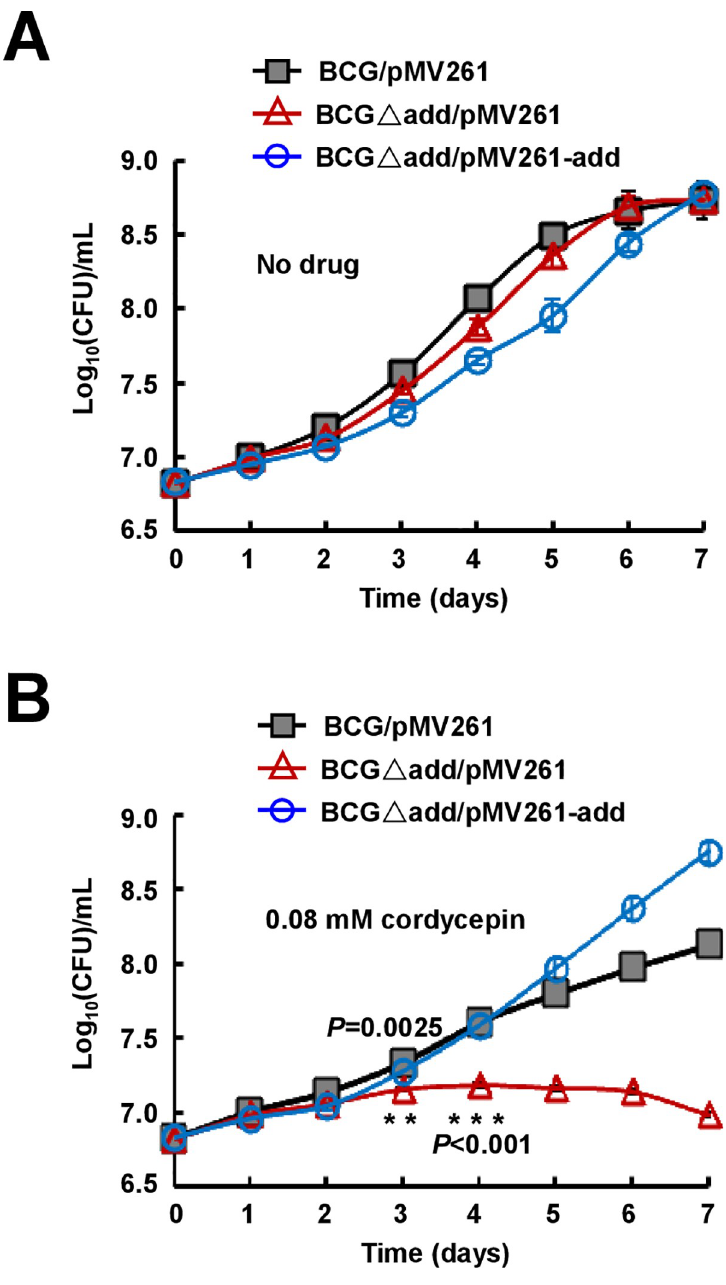
Fig 5. Effects of adenosine deaminase shunt on the mycobactericidal activity of cordycepin. Mycobacterial strains were grown in 7H9 medium without (A) or with 0.08 mM cordycepin (B). The add -deleted BCG strain is more sensitive to cordycepin than wildtype strain. Asterisks ( � ) denote a significant difference between the add -deleted and wildtype strain, and the P -values are indicated. The P -values were calculated by unpaired two-tailed Student’s t -test using GraphPad Prism